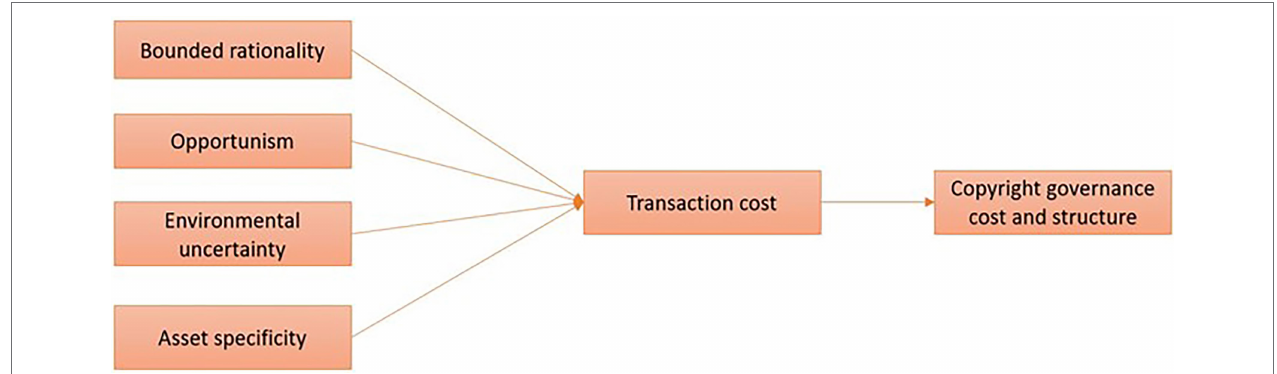
FIGURE 1 | Analytical framework under transaction cost economics